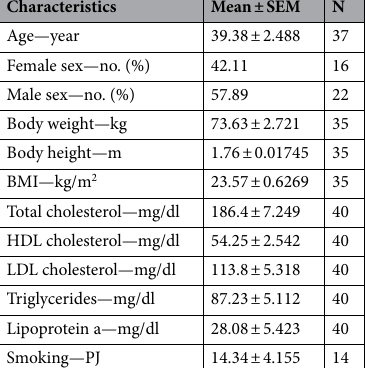
Table 2. Clinical characteristics of the cohort of control patients analyzed in this